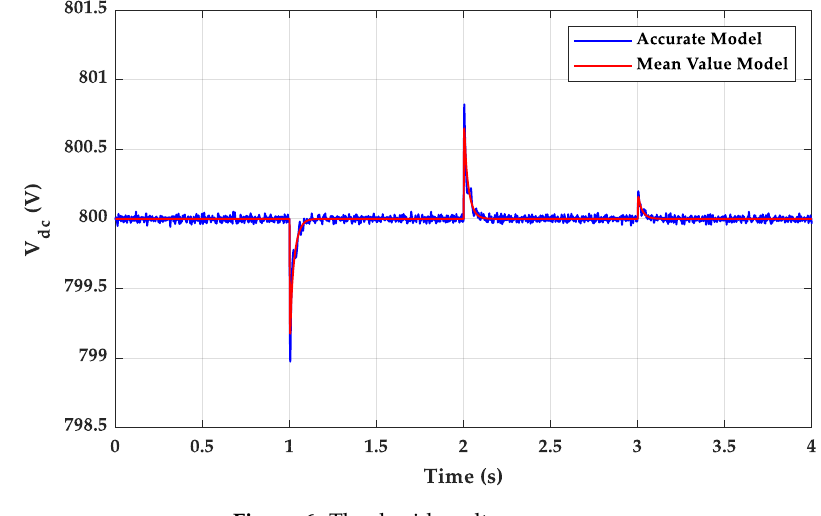
Energies 2019 , 12 , x FOR PEER REVIEW